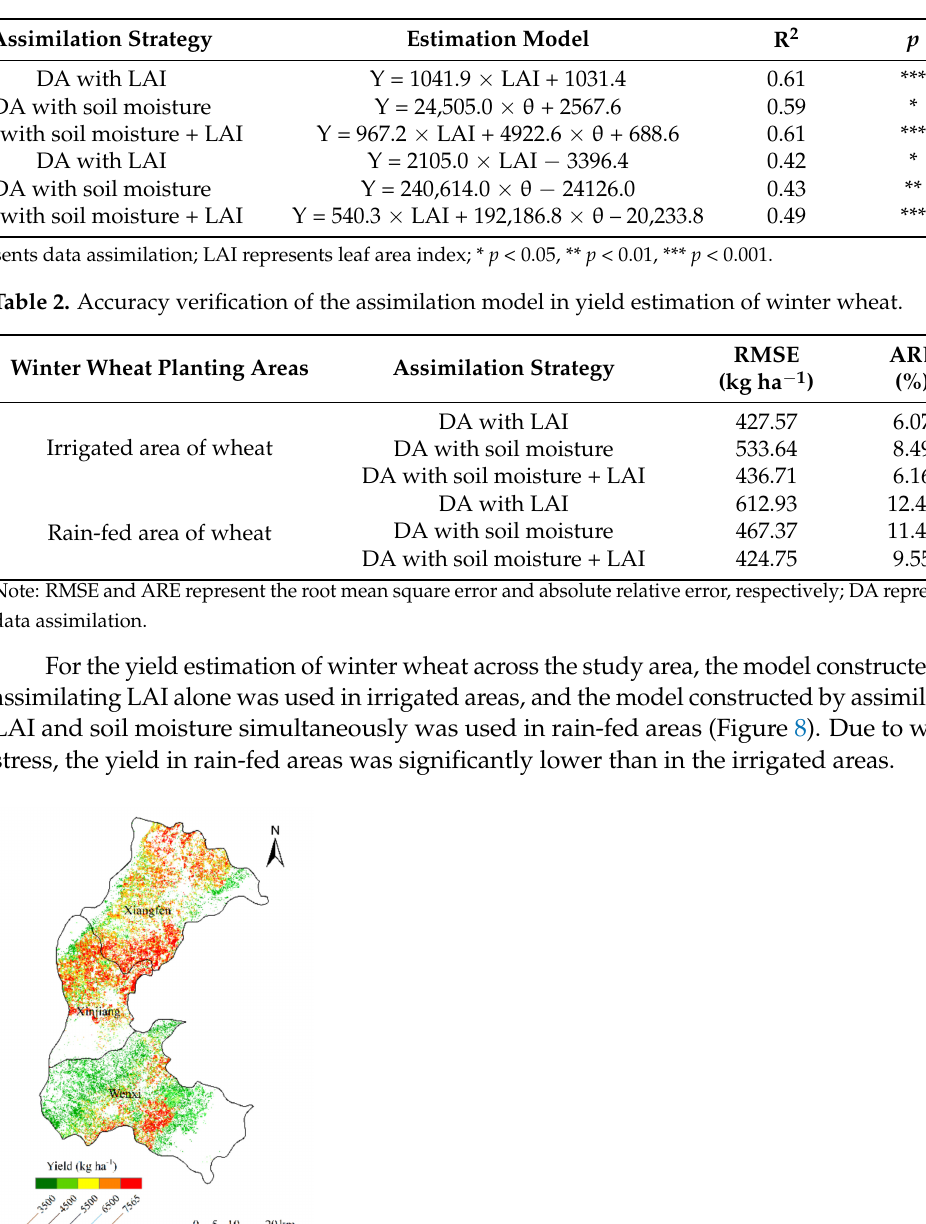
Table 1. Models of yield estimation for wheat using different assimilation strategies.